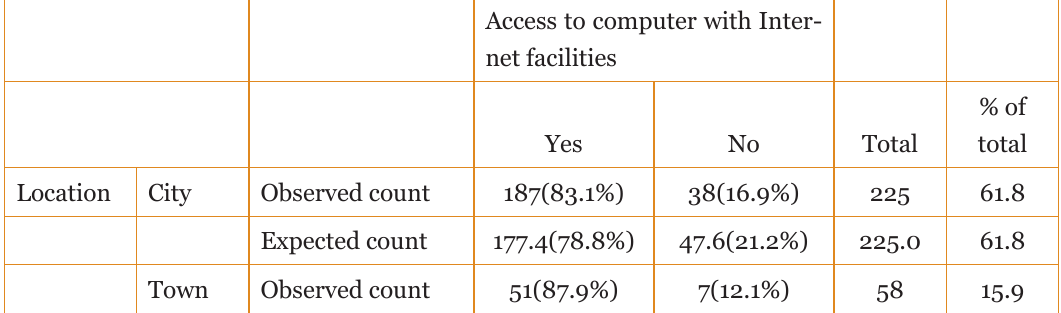
Access to computer with